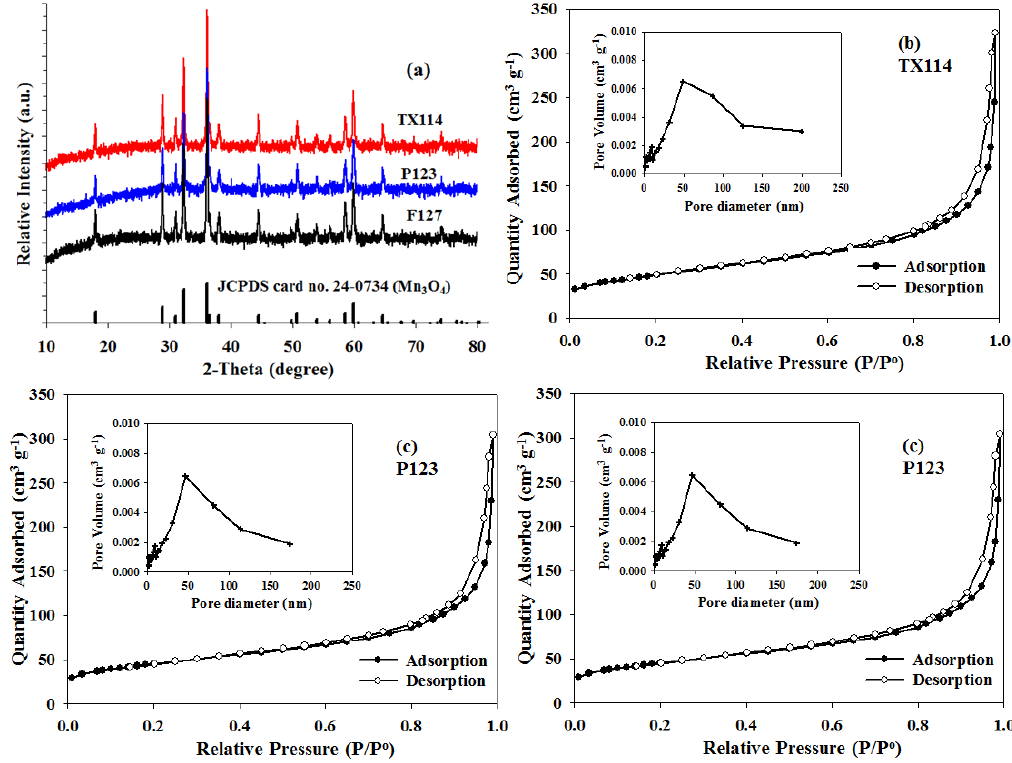
Figure 2. ( a ) X-ray diffraction (XRD) patterns for a theoretical pattern, Pluronic F-127 (F127), Pluronic P-123 (P123), and Trition X-114 (TX114) and N 2 adsorption-desorption isotherms and the pore-size distribution plots (insert) for ( b ) TX114; ( c ) P123; and ( d ) F127.